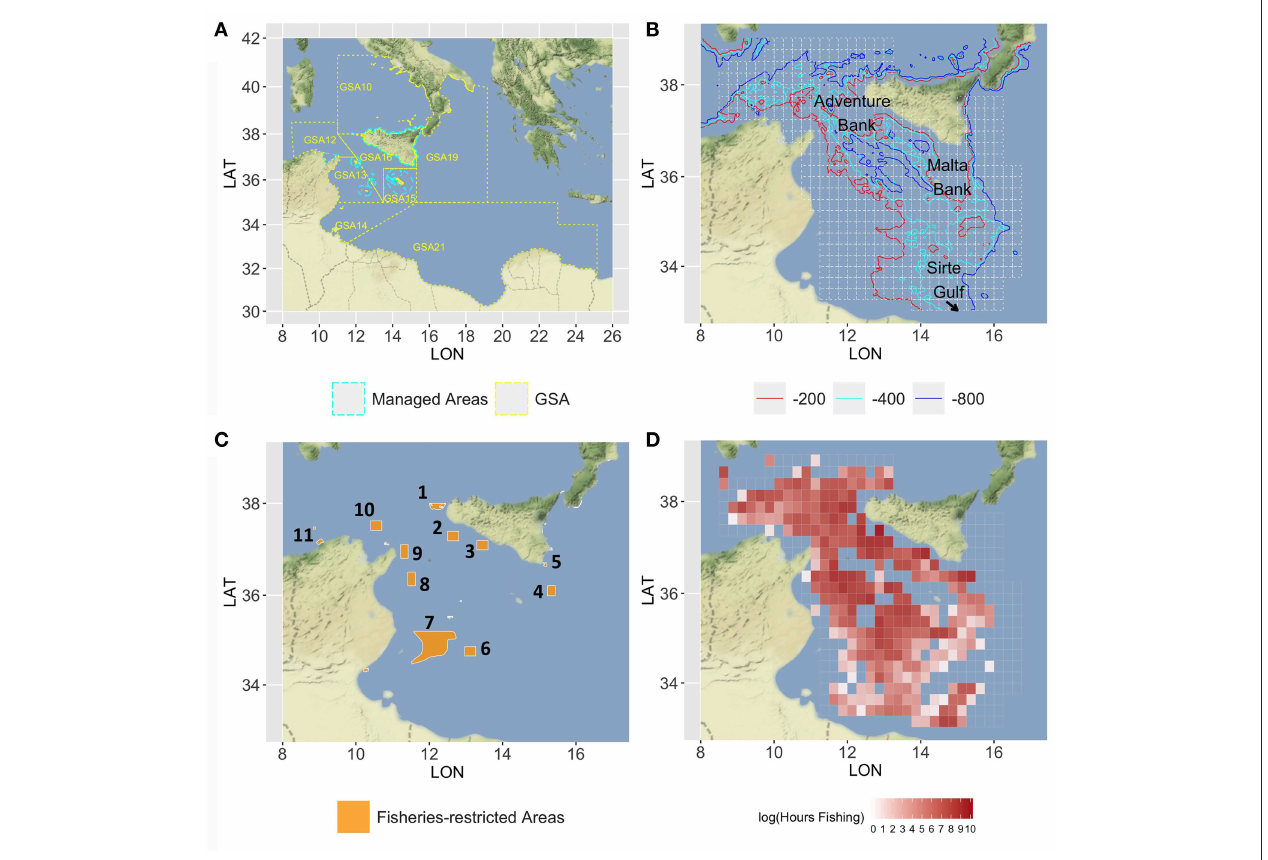
FIGURE 1 | Map of the Strait of Sicily, in which (A) the GSAs 12–16, 19, and 21 are represented with the managed areas (in cyan dashed lines) where trawl fishing is forbidden; (B) the main bathymetries ( − 200, − 400, and − 800) are represented together with the 15 × 15 nautical miles grid (in gray) used to set up the model; (C) the network of the nine areas considered for the spatial scenarios are represented by orange polygons, numbered in a clockwise order: 1, Egadi islands; 2, East of Adventure Bank; 3, West of Gela Bank; 4, East of Malta Bank; 5, Capo Passero; 6, “Fondaletto”; 7, “Mammellone”; 8, West of Pantelleria; 9, Cape Bon shoal; 10, Skerki Bank; 11, Galite Bank; (D) the mean annual fishing effort, in the period 2012–2016, is represented with a red-scale color (log of total fishing hours). Figures were created using the R package ggmap ( Kahle and Wickham, 2013) using Map tiles by Stamen Design, under CC BY 3.0 and data by OpenStreetMap contributors (2017)